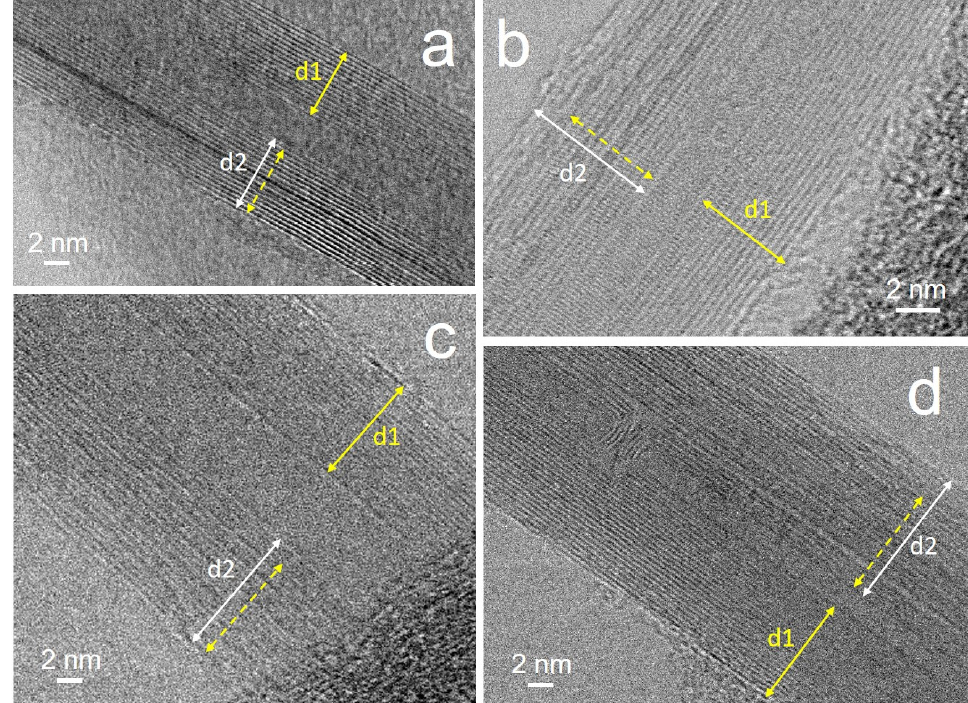
Figure 5. Examples of asymmetric thickness of the overall MWCNT walls: “d2” is the thickness of the side of the MWCNT wall containing iodine line(s); “d1” is the thickness of the iodine-free side; dividing each d1 segment from the four images by the number of related intershell spacings provided average “regular” intershell distances ranging from 0.35 to 0.375 nm; the dashed segment is a duplicate of the d1 segment put alongside d2 for better comparison of length differences. ( a ) The d2 side contained one iodine line (see the corresponding HAADF image in Supplementary Materials, Figure S1); ( b ) the d2 side contained 3 iodine lines (the corresponding HAADF image is Figure 3b); ( c ) iodine was present in the d2 side, but the number of iodine lines was hard to ascertain (see the corresponding HAADF image in Supplementary Materials, Figure S2); ( d ) the d2 side contained 4 iodine lines (the corresponding HAADF image is Figure